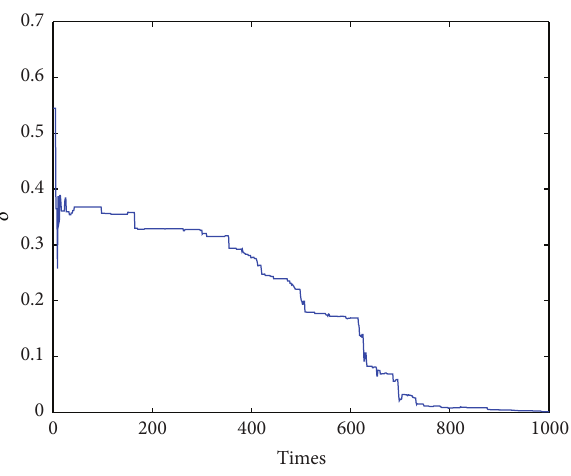
Figure 3: The results of nonlinear function needing to be optimized versus Times